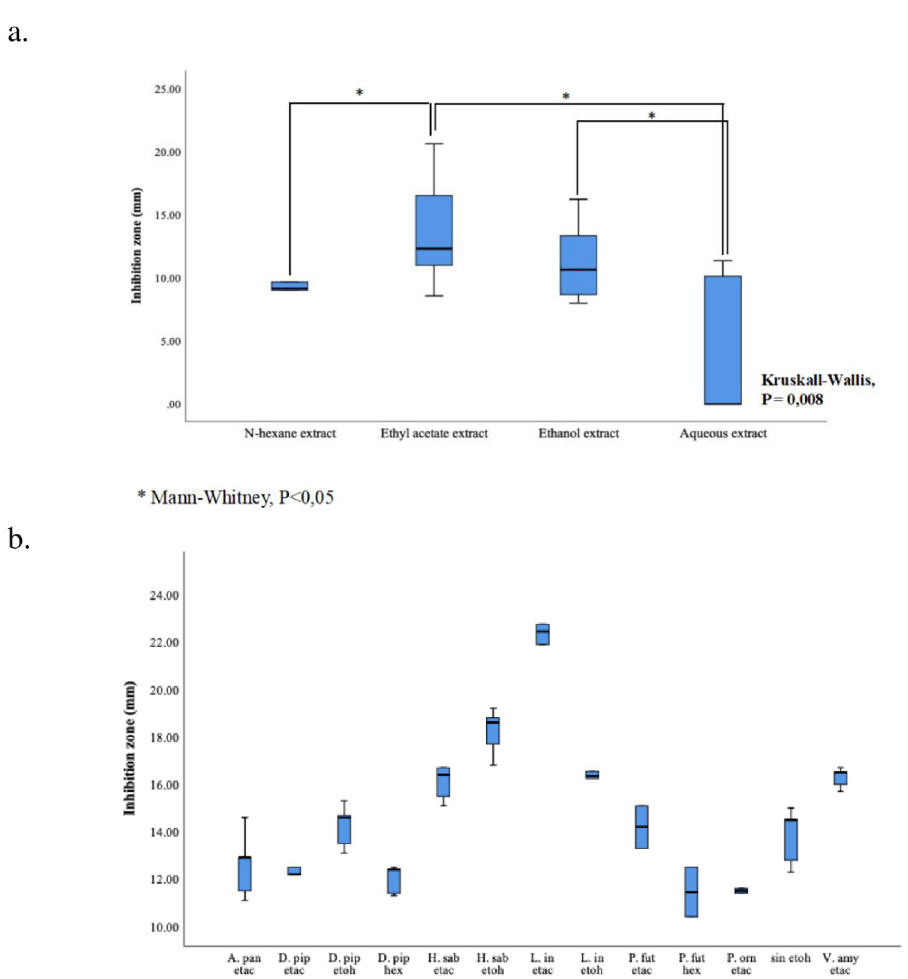
Fig 1. Comparison of antibacterial activity of plant extracts by disc diffusion. a) Inhibition zone of extracts on ATCC 49619 in various solvent. b) Inhibition zones of plant extracts on multi-drug resistant strain S . pneumoniae . Extract-impregnated disc (6mg/disc) was used to obtain inhibition zone performed on sheep blood (5%) Mueller- Hinton agar. The incubation was done at 37˚C with 5% CO 2 for 20 hours. A. pan etac; Andrographis paniculate ethyl acetate extract, D. pip etac; Drymis piperita ethyl acetate extract, D. pip etoh; Drymis piperita ethanol extract, D. pip hex; Drymis piperita n-hexane extract H. sab etac; Hibiscus sabdariffa ethyl acetate extract, H. sab etoh; Hibiscus sabdariffa ethanol extract, L. in etac; Lawsonia inermis ethyl acetate extract, L. in etoh; Lawsonia inermis ethanol extract P. fut etac; Passiflora foetida ethyl acetate extract, P. fut hex; Passiflora foetida n-hexane extract, P. orn etac; Piper ornatum ethyl acetate extract, Sin etoh; Sinsus ethanol extract, V. amy etac; Vernonia amygdalina ethyl acetate extract. � Mann-Whitney U test (P < 0,05).